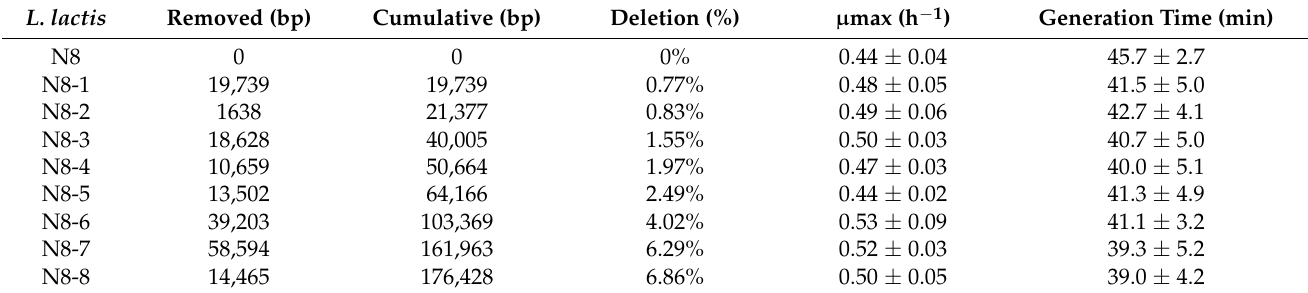
Table 6. Growth parameters in shaken-flask cultures of L. lactis